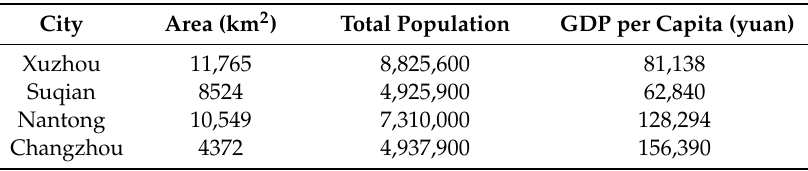
Table 1. Basic information of the four cities in Jiangsu in 2019.